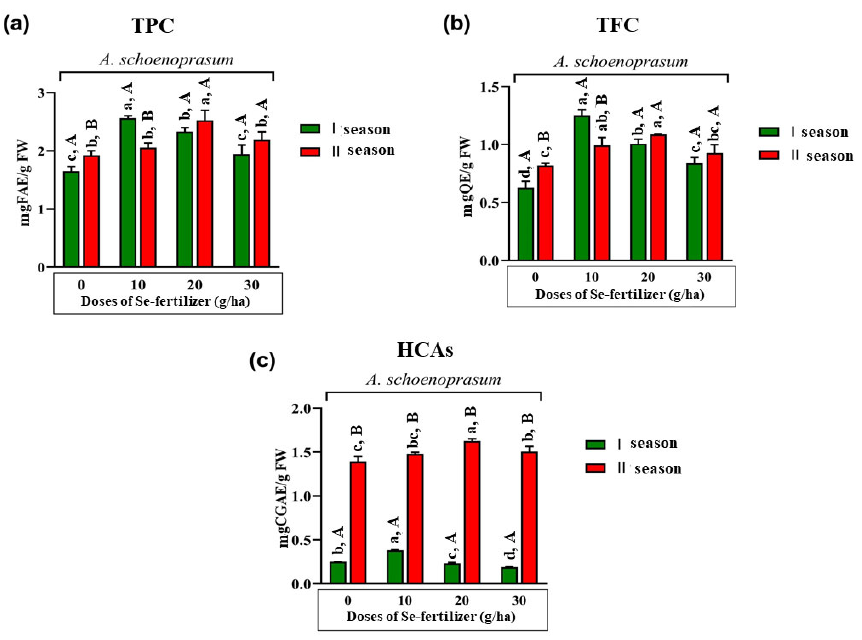
Figure 2. Effect of different doses (control—0, 10, 20 and 30 g per ha) of Se fertilizer and growing season on the total content of free phenolics (TPC) ( a ), total content of free flavonoids (TFC) ( b ) and total content of free hydroxycinnamic acid derivatives (HCAs) ( c ) in the edible parts (leaves) of A. schoenoprasum . The bars with (+) standard deviation represent mean values; lowercase letters indicate comparisons between treatments (applied doses of Se ‐ fertilizer (g/ha)); uppercase letters indicate comparisons between seasons; different letters indicate statistically significant differences according to Tukey’s HSD test ( p < 0.05). n.d.—not detected; FAE—ferulic acid equivalents; QE—quercetin equivalents; CGAE—chlorogenic acid equivalents.